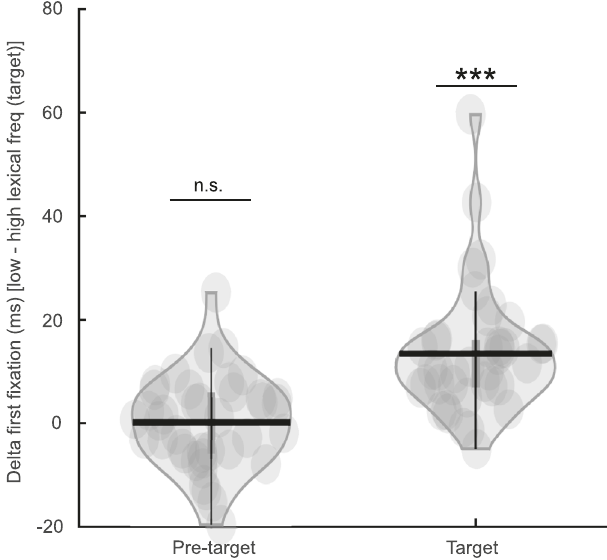
Fig. 2 Eye movement metrics. The fi rst fi xation duration difference for pre- target and target words when comparing low versus high lexical frequency target words. (*** p = 2.97 × 10e − 8, n = 39, two-sided pairwise t -test). The horizontal bar in the violin plots indicates the mean value; each dot represents one participant. Source data are provided as a Source Data fi le.